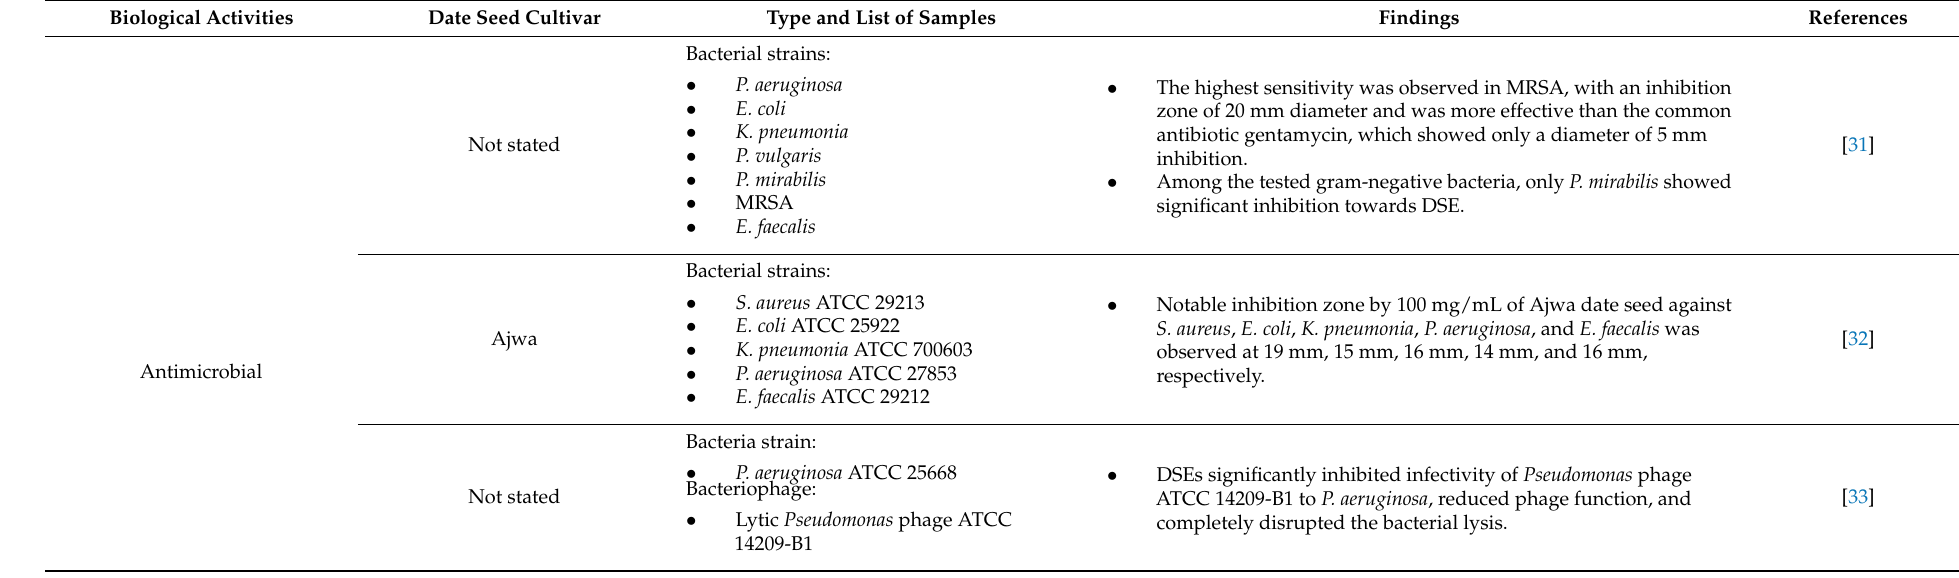
Table 2. A summary of biological activities of date